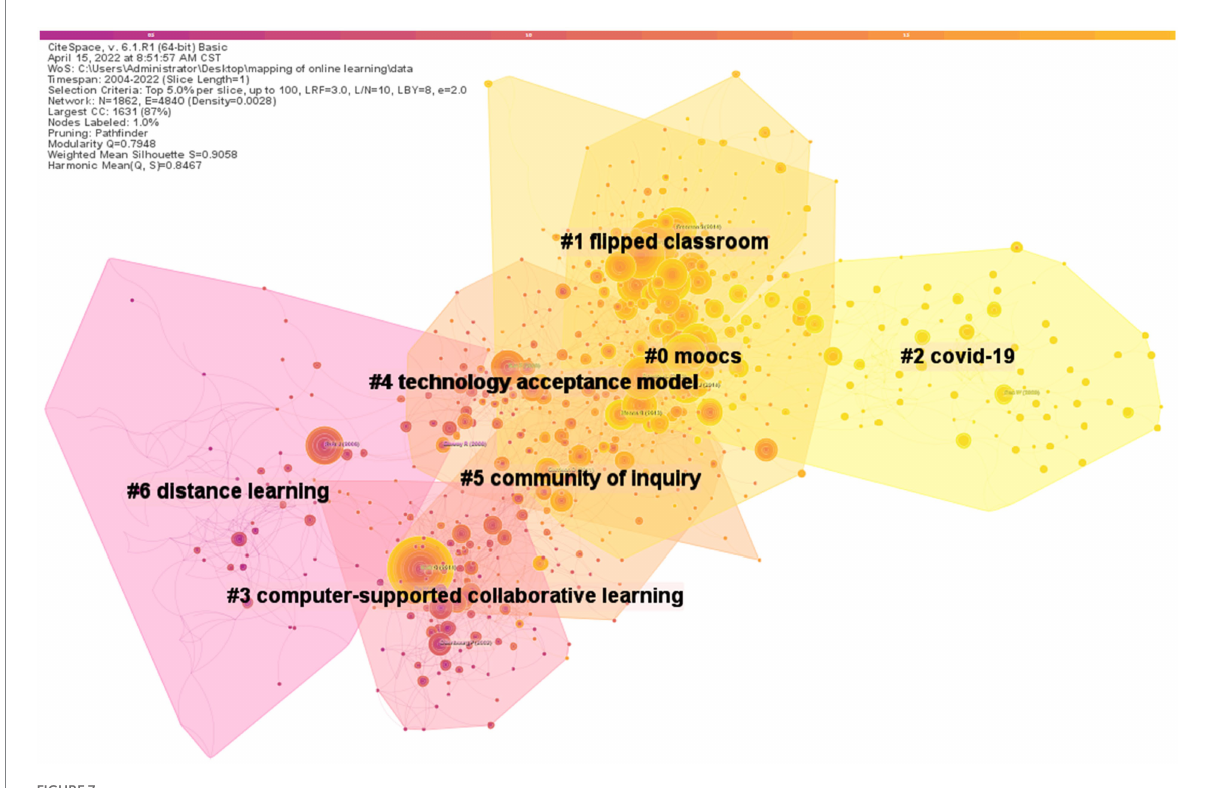
FIGURE 7 Co-citation clusters of cited references.